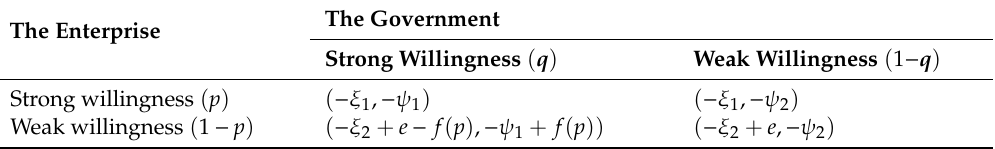
Table 9. The payo ff matrix under the dynamic punishment mechanism (DPM).